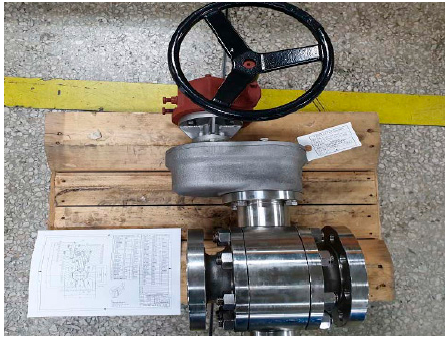
Figure 7. Prototype of the proposed cylinder-in-ball valve.